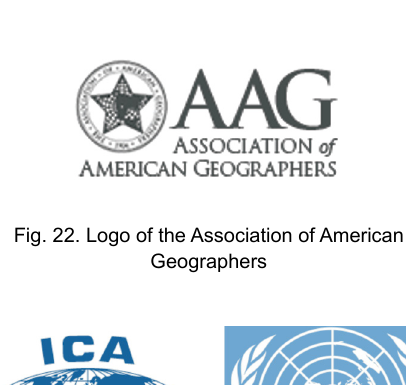
Fig. 21. Retro-azimuthal map projection for Mecca (https://www.mapthematics.com)